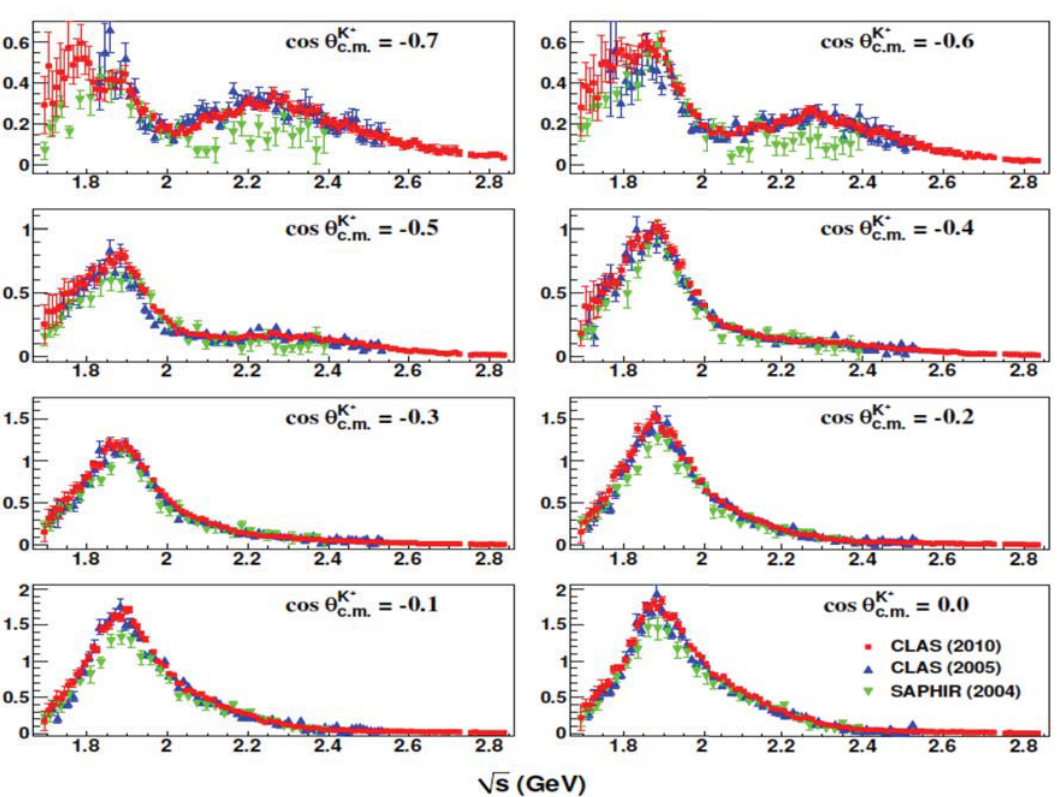
Fig. 3 Invariant mass dependence of the γp → K + Σ ◦ differential cross section in the backward polar angle